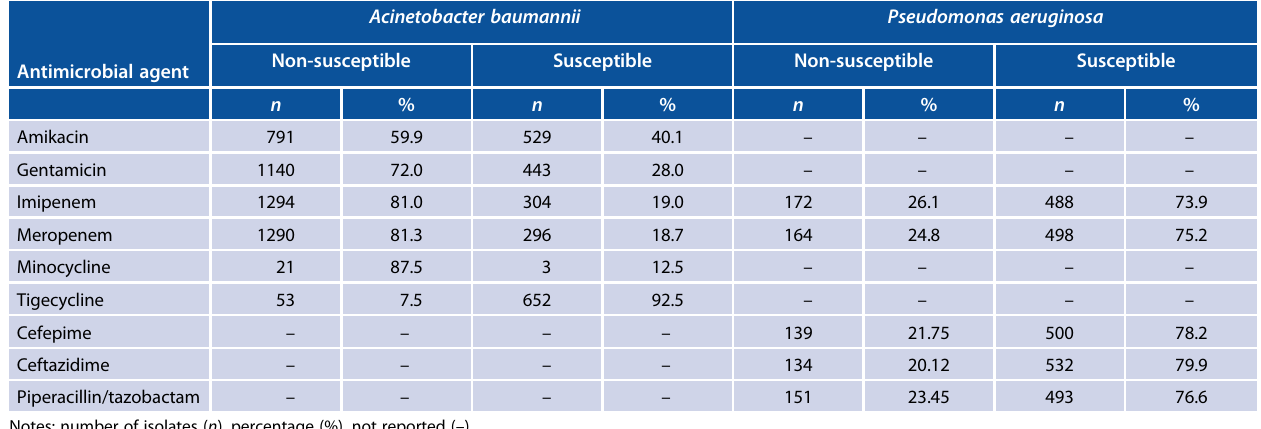
Figure 3: Number of non-fermenters: Acinetobacter baumannii ( n = 1 637) and Pseudomonas aeruginosa ( n = 681) reported from 16 sentinel hospitals across South Africa, January 1, 2016 to December 31, 2016. Table 6: Antimicrobial susceptibility patterns of non-fermenters isolated from blood cultures reported from 16 sentinel hospitals across South Africa, January 1, 2016 to December 31, 2016